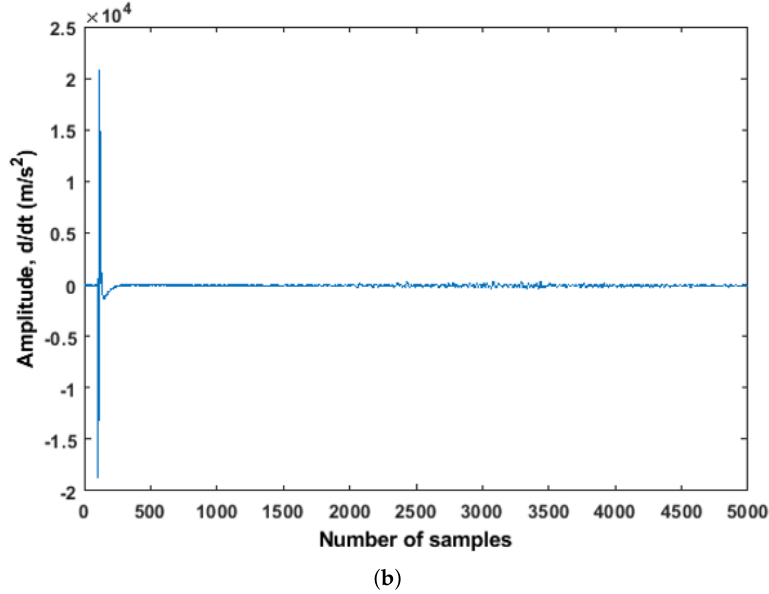
Figure 9. Raw signals acquired from the two pairs of sensors are shown. ( a ) Raw signal acquired from the sensor pair S12R14 (distance between sensors was of 1 m); ( b ) Raw signal acquired from the sensor pair S10R12 (distance between sensors was of 5.5